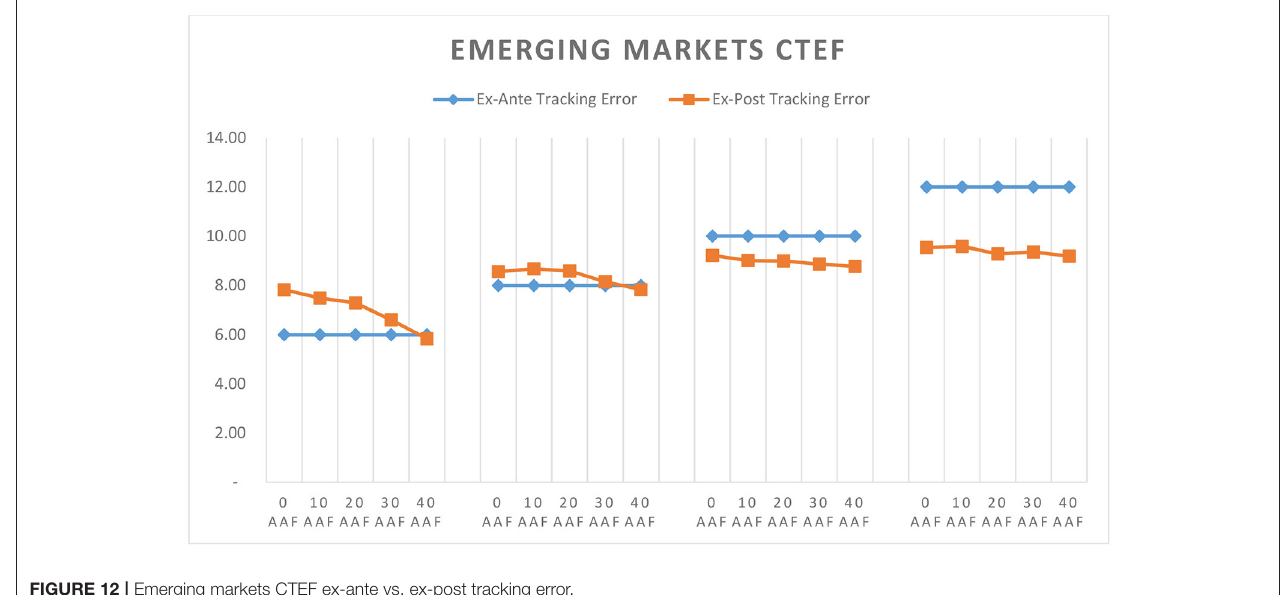
FIGURE 12 | Emerging markets CTEF ex-ante vs. ex-post tracking error.